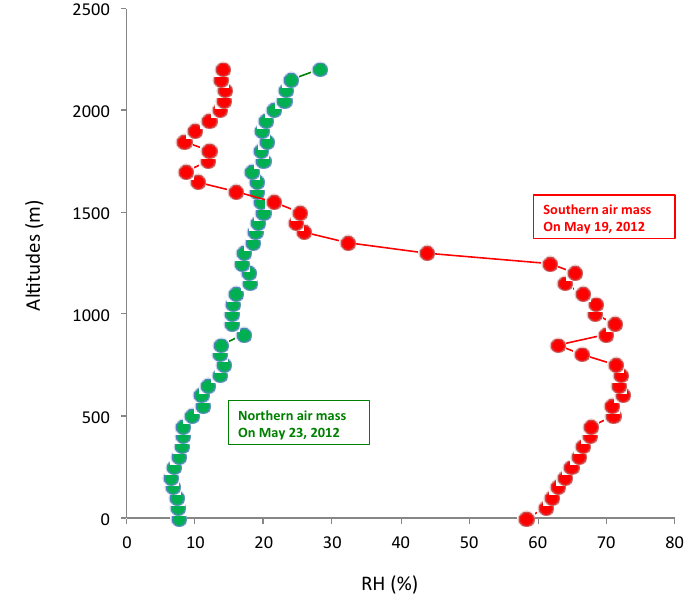
Figure 9. The vertical distributions of relative humidity (RH) during a typical southern air mass (red) and northern air mass (green) in the urban area